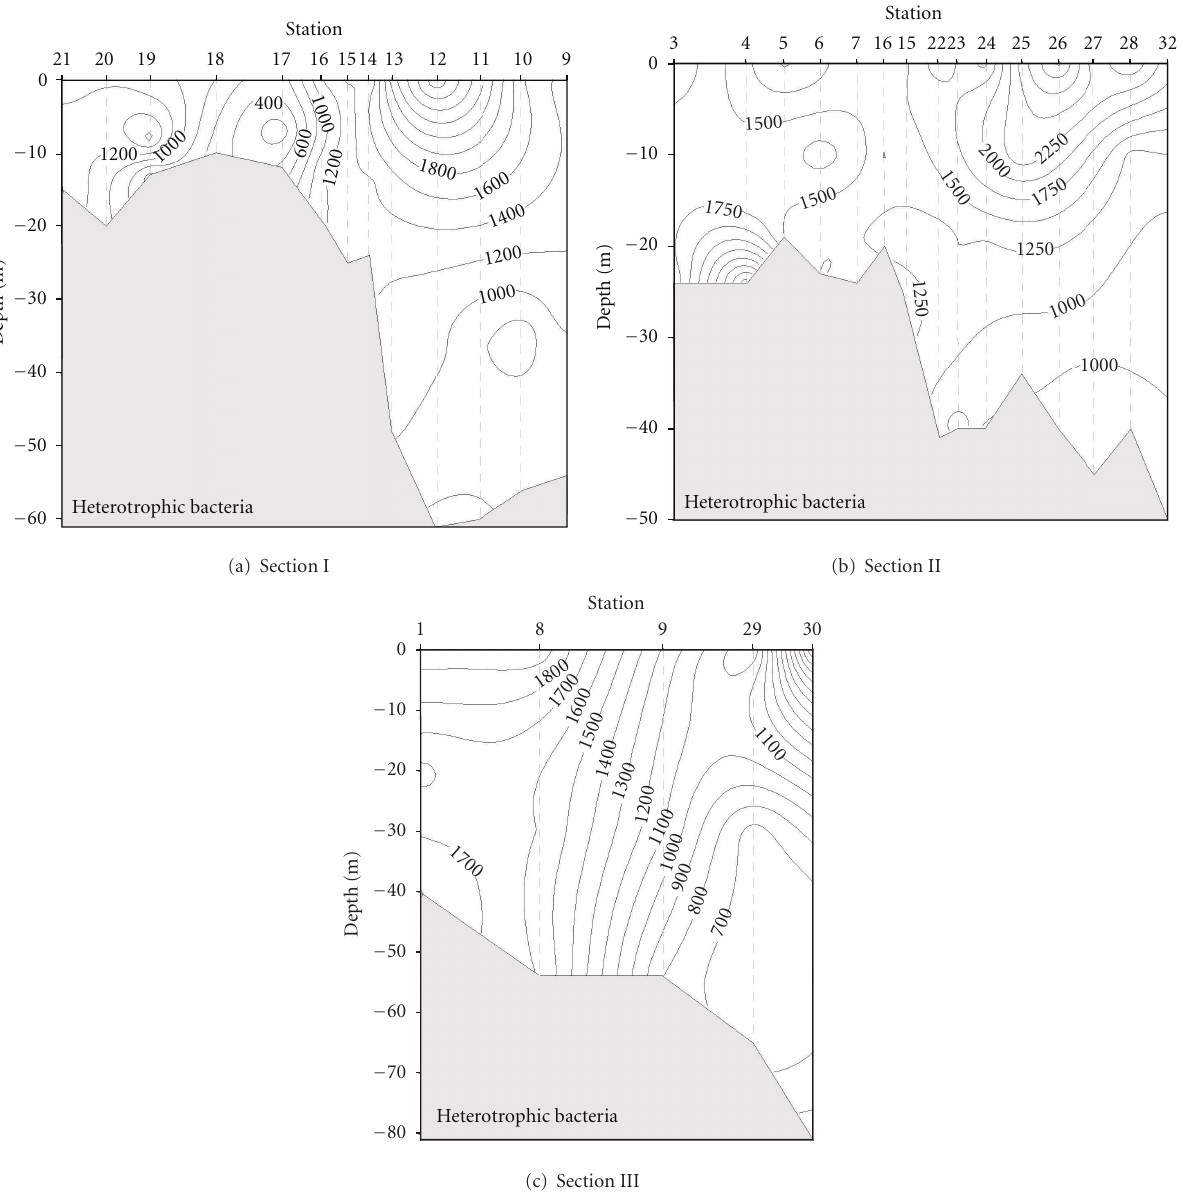
Figure 4: Spatial distribution of heterotrophic bacteria ( × 10 6 cells L − 1 ) in the Changjiang estuary and its adjacent sea area in June 2006.